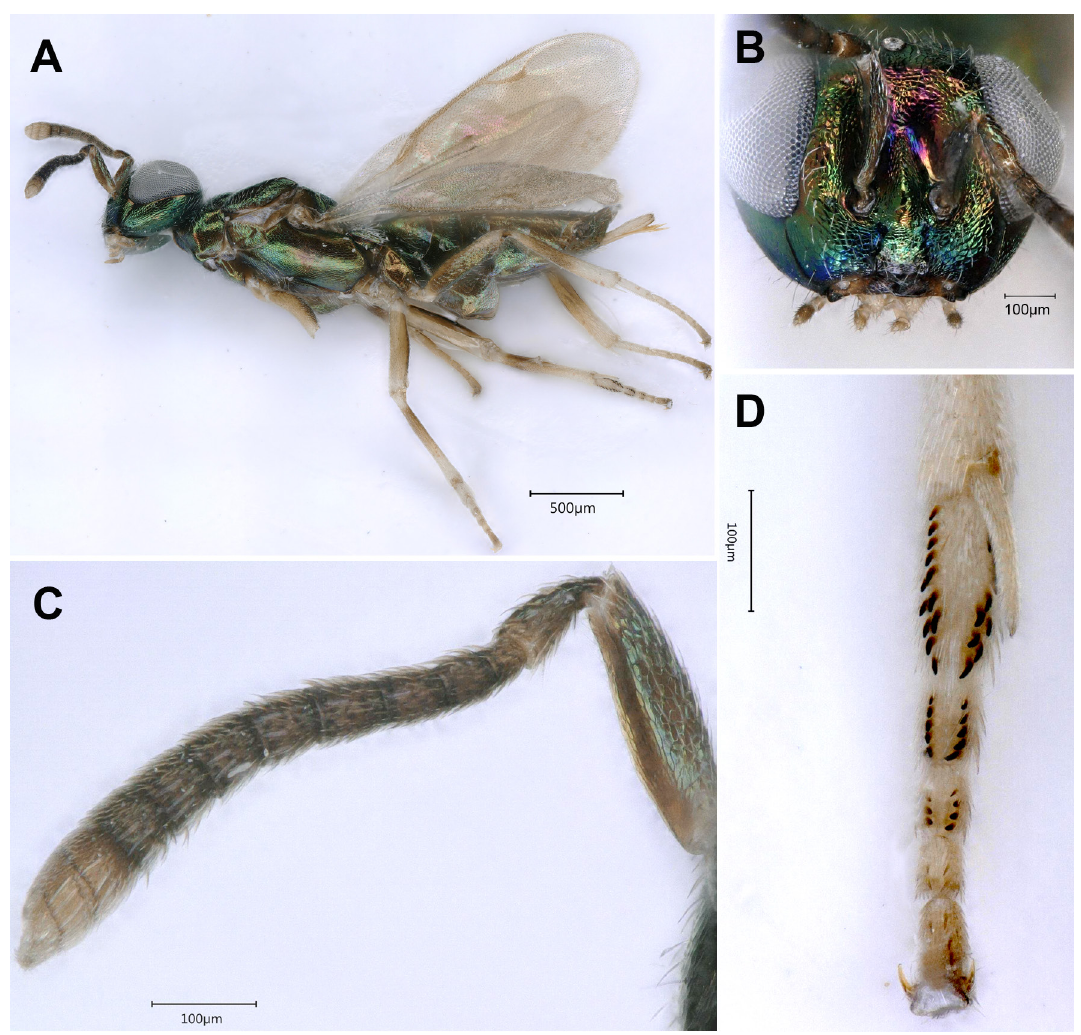
Fig. 7. Eupelmus phragmitis Erdös, 1955. A . Female in lateral view. B . Head in frontal view. C . Antenna of female. D . Mid tarsus in ventral